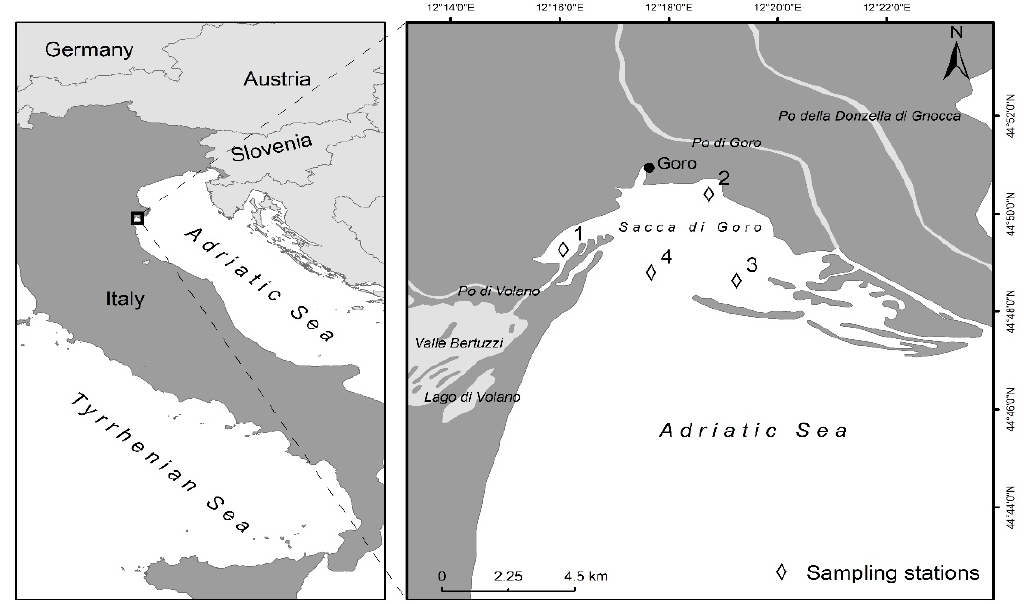
Figure 1. Map of the Sacca di Goro Lagoon and location of sampling sites.